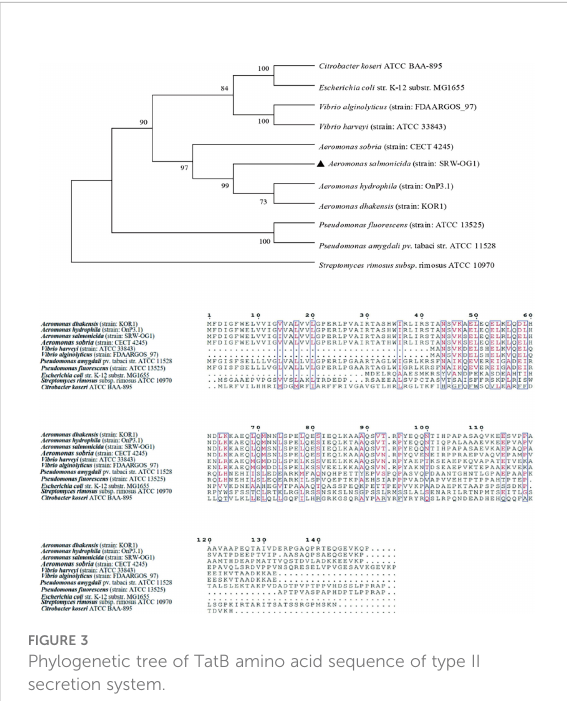
FIGURE 2 Phylogenetic tree of TatA amino acid sequence of type II secretion system.